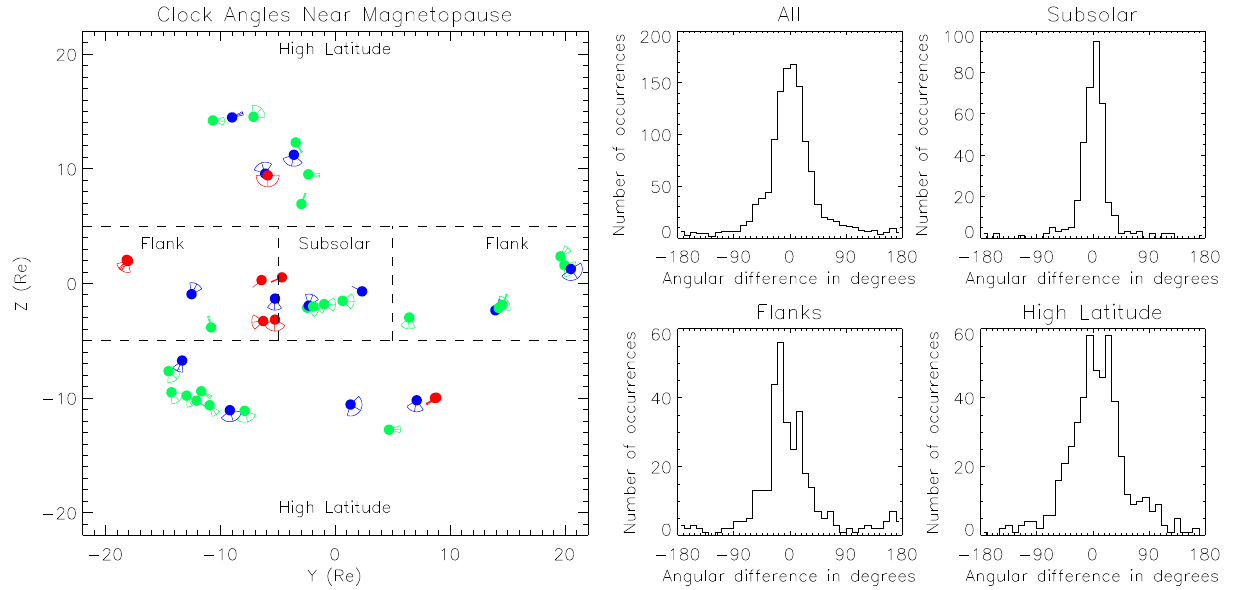
Fig. 2. Clock angles measured near magnetopause, and angular differences from perfect draping, for unsmoothed data. The mean position of the data points (in GSM coordinates) within each 2 R E bin is shown as a filled circle, and the mean clock angle is indicated by a line. The standard deviation of the clock angles within each bin is indicated by an arc of total angular extent equal to twice the standard deviation. The colour coding indicates the difference between the mean clock angle measured near the magnetopause, and that observed in the corresponding upstream IMF data: green for a difference of less than 30 ◦ , blue for a difference between 30 ◦ and 90 ◦ , and red where the difference is greater than 90 ◦ . The histograms show the distribution of angular differences over the entire magnetopause (“All”), and the subsolar, flank, and high latitude regions. The extent of these regions is shown on the magnetopause